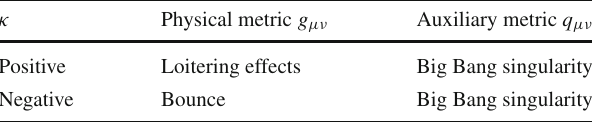
Table 1 This table summarizes how the EiBI theory of gravity cures theBigBangsingularityinaradiationdominateduniverse.If κ > 0,the Big Bang singularity in the physical metric is replaced with a loitering stage in which the universe gets its minimum size in the infinite past. If κ < 0, the physical metric is described by a bouncing scenario in the past. However, there is still a Big Bang singularity in the auxiliary metric for both